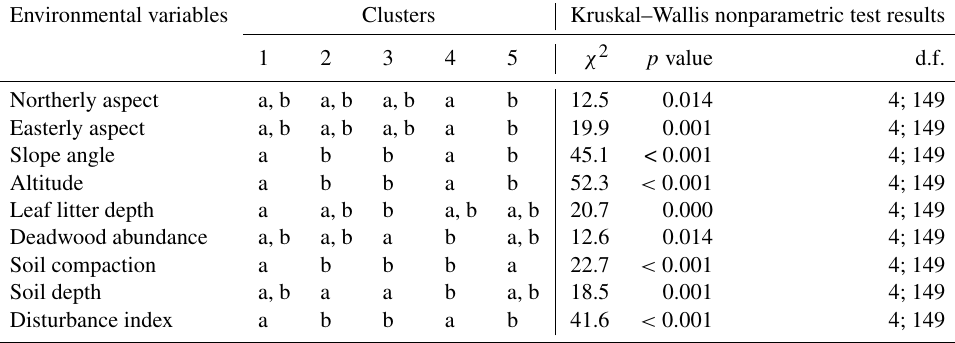
Table F1. A Kruskal–Wallis nonparametric test on selected environmental variables for the five clusters of canopy trees (plot layer) defined by the NMDS analysis of canopy trees in Fig. 3. Letters indicate groups that do not significantly differ within rows ( p < 0.05). χ 2 is